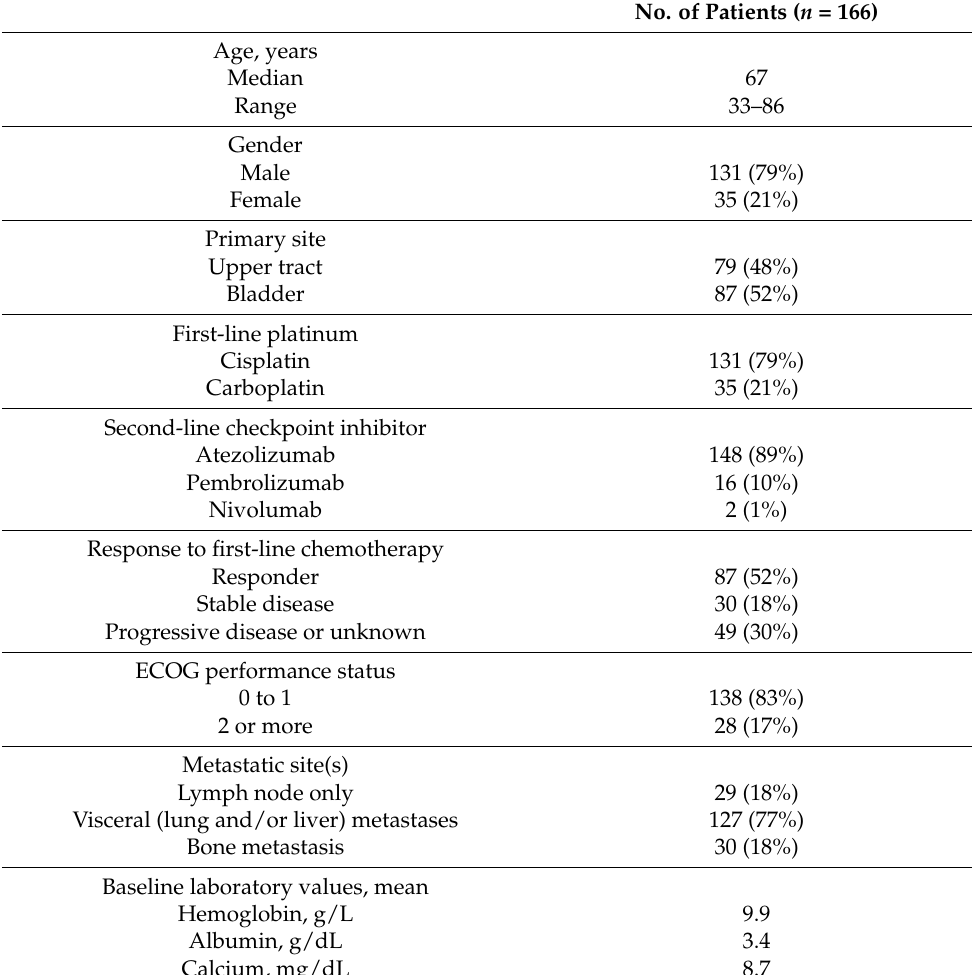
Table 1. Patient characteristics at the time of third-line therapy.